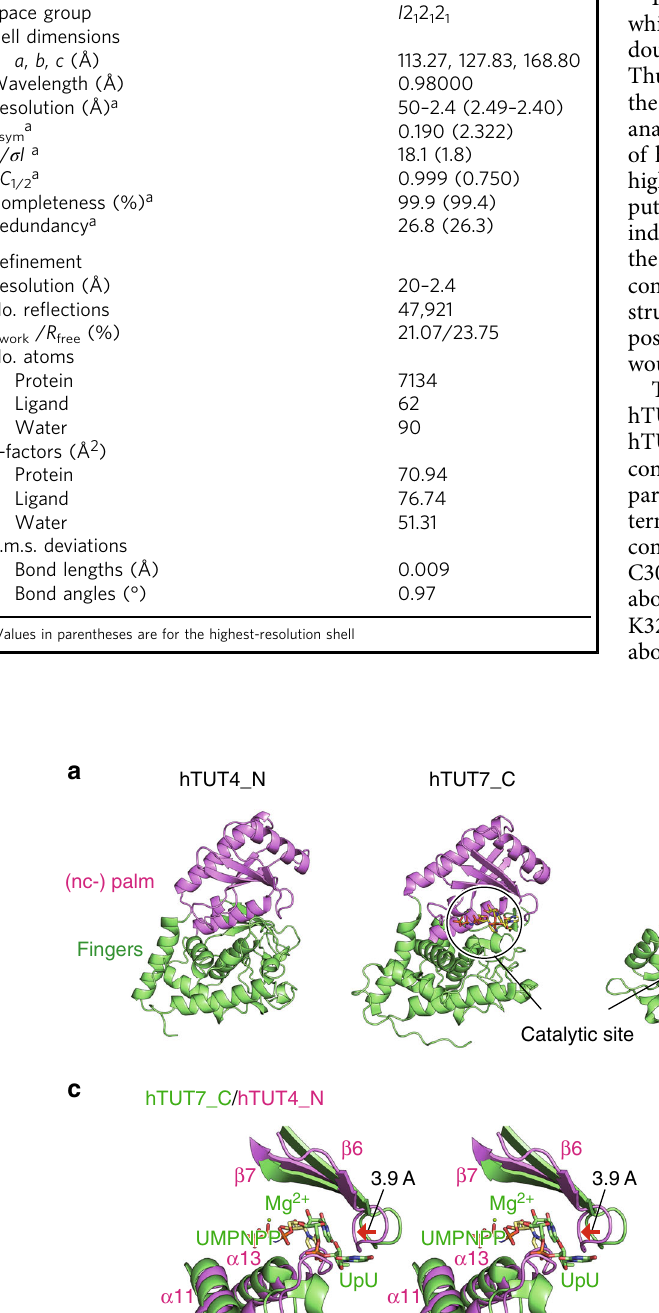
Data collection Space